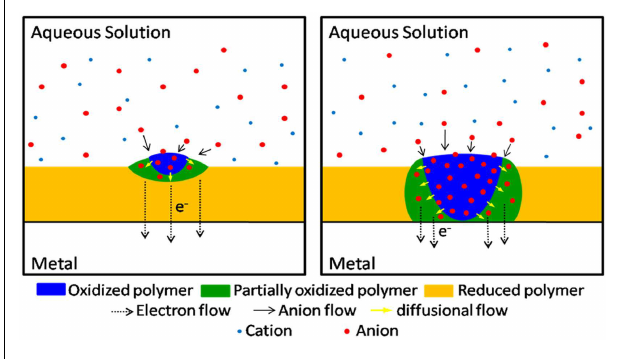
FIGURE 4 | Scheme of the oxidation according to the ESCR model: the oxidation of conformational packed and reduced film of any conducting polymer starts by nucleation–relaxation at the polymer/solution interface